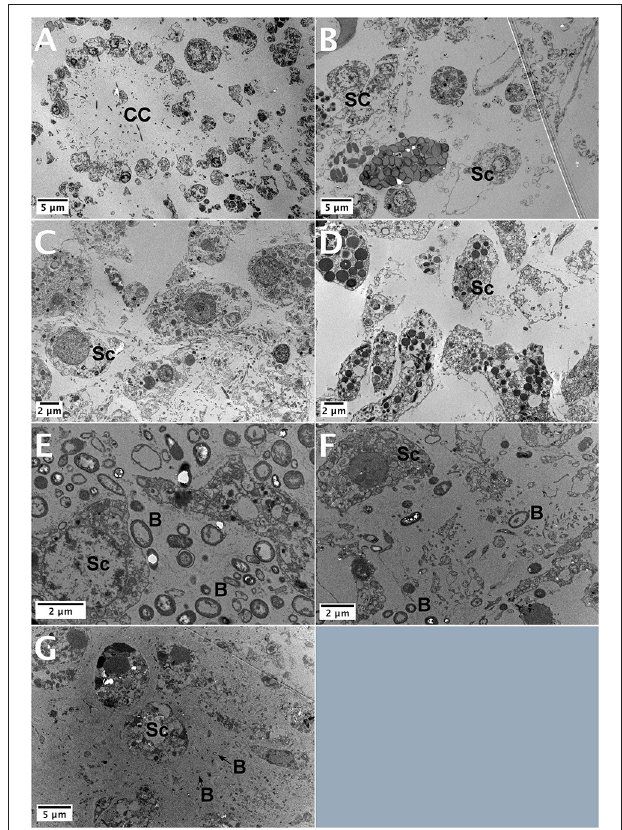
FIGURE 9 | TEM images of the study sponges (A) Haliclona sp., (B) Calyspongia sp., (C) Amorphinopsis foetida, (D) Suberites carnosus, (E) High abundance of bacterial cells present in the Ircinia fusca mesohyl, (F) Biemna fortis, and (G) Cinachyrella cf. cavernosa showing a moderate abundance of bacterial cells in the mesohyl. CC, choanocyte chamber; Sc, sponge cell; B, bacterial cell.